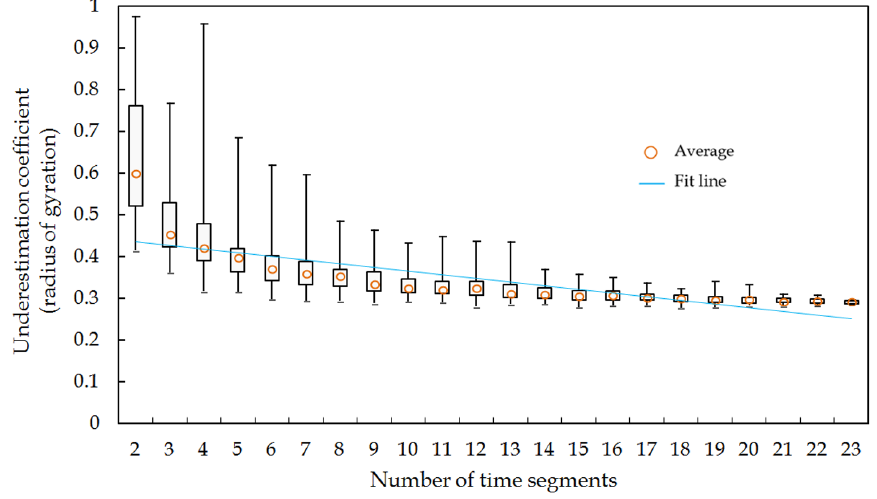
Figure 12. Distribution of aggregated underestimation coefficients for estimating radius of gyration using different numbers of time segments.